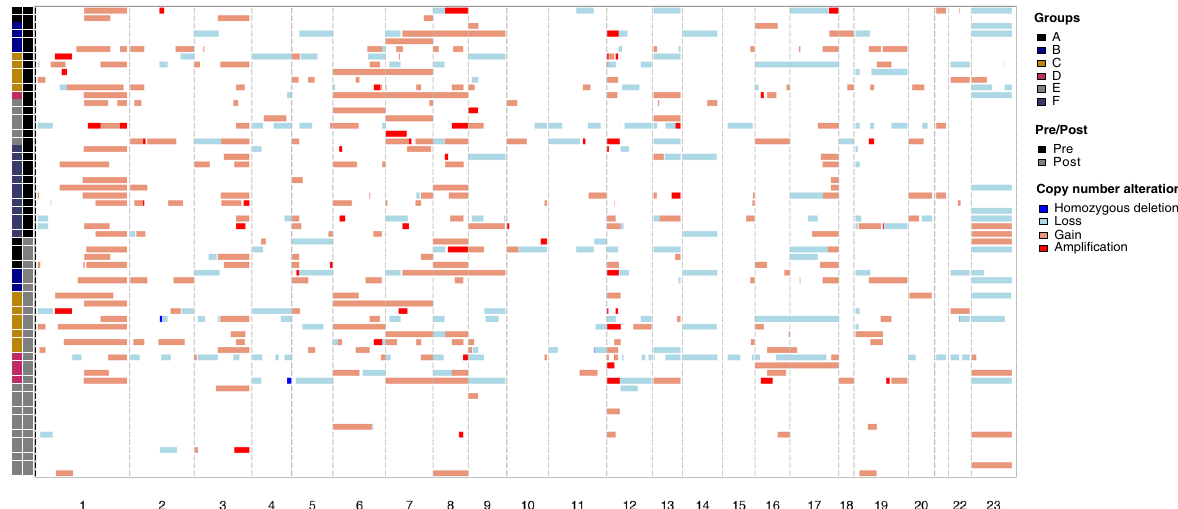
Fig. 2 Copy number alterations in 61 pre/post-treatment TNBCs. A heatmap shows the ampli fi cations, gains, losses, and homozygous deletions across all